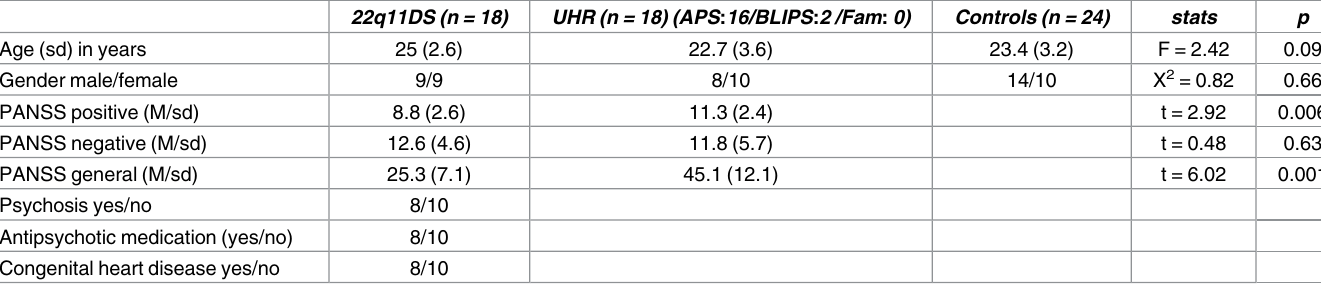
Table 1. Demographic and clinical